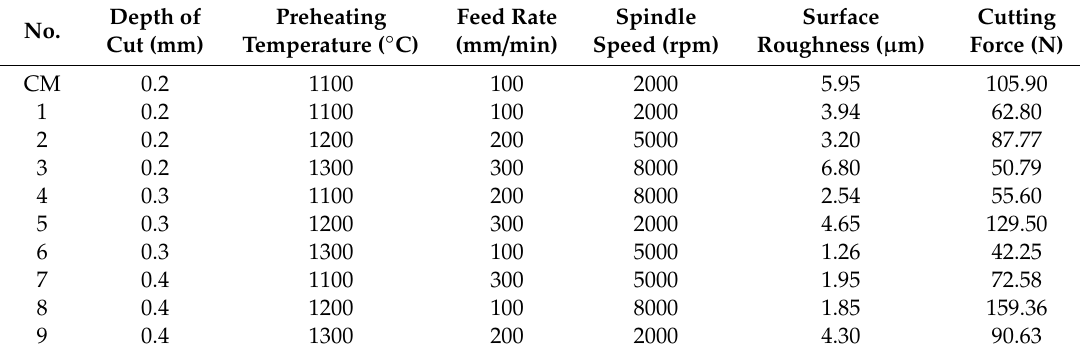
Table 6. The experimental data value of cutting force and surface